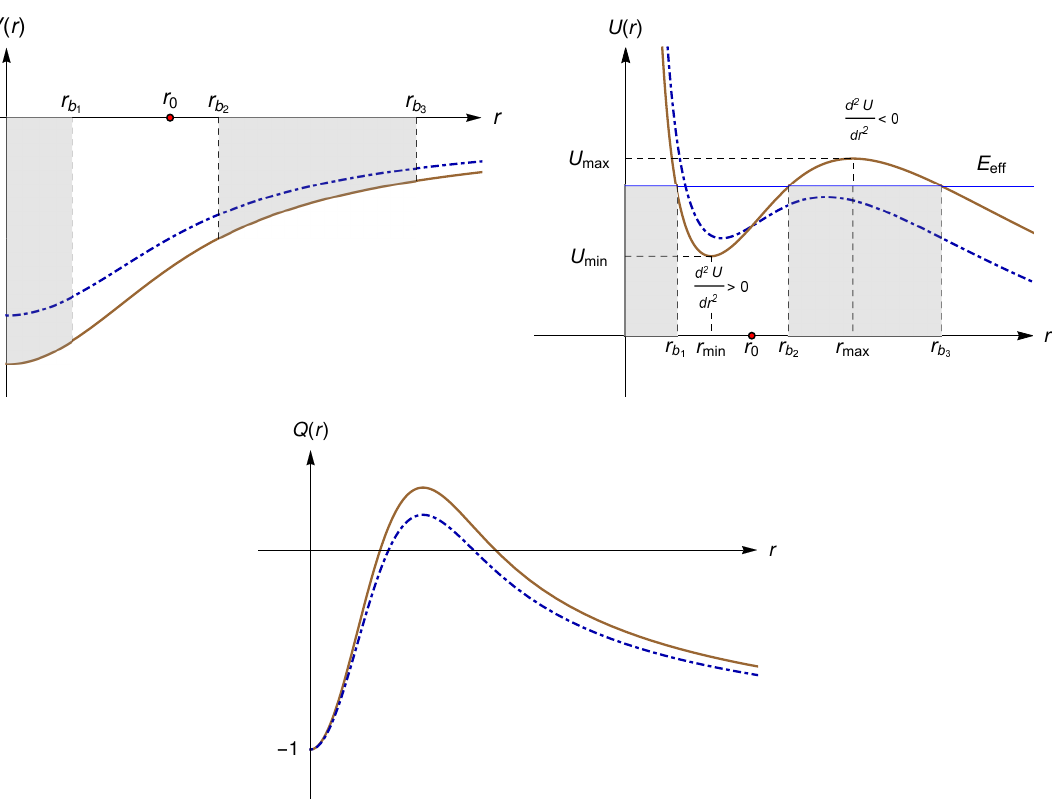
Figure 1 . Qualitative plots showing the comparison between V ( r ) , U ( r ) , and Q ( r ) in the case where the scattering potential V ( r ) satisfies the requirements (i)–(ii). The shaded areas represent the forbidden values for the radial coordinate r ( t ) , where U ( r ) > 1 / 2 = E . Although V ( r ) is eff always negative, the effective potential U ( r ) is a positive-defined function. The red dot represents the initial condition r . For the solid-line curves, all the conditions in (2.30) are satisfied. In this 0 case, since r , the bounded solutions are allowed; the time evolution of r ( t ) is confined b 1 < r 0 < r b 2 in between r and r . Although U is only a local minimum, the region [ r + ∞ ] (while in b 1 b 2 min b 3 , principle not forbidden) remains inaccessible to the system. Indeed, accessing such region (with the initial condition shown in the plot) would constitute a violation of the condition (2.7), which means a velocity greater than the speed of the light. For this reason, the bounded movement is stable, and in order to break the confinement the particle must be a tachyon. The dot-dashed line represents the case where (I) in (2.30) is satisfied while the condition (II) is violated. Despite the fact that Q max > 0 because (II) is not true, there exist only a single turning point where U ( r b ) = E eff . Hence, the particles will scatter through the infinity, and bounded solutions are not possible in this